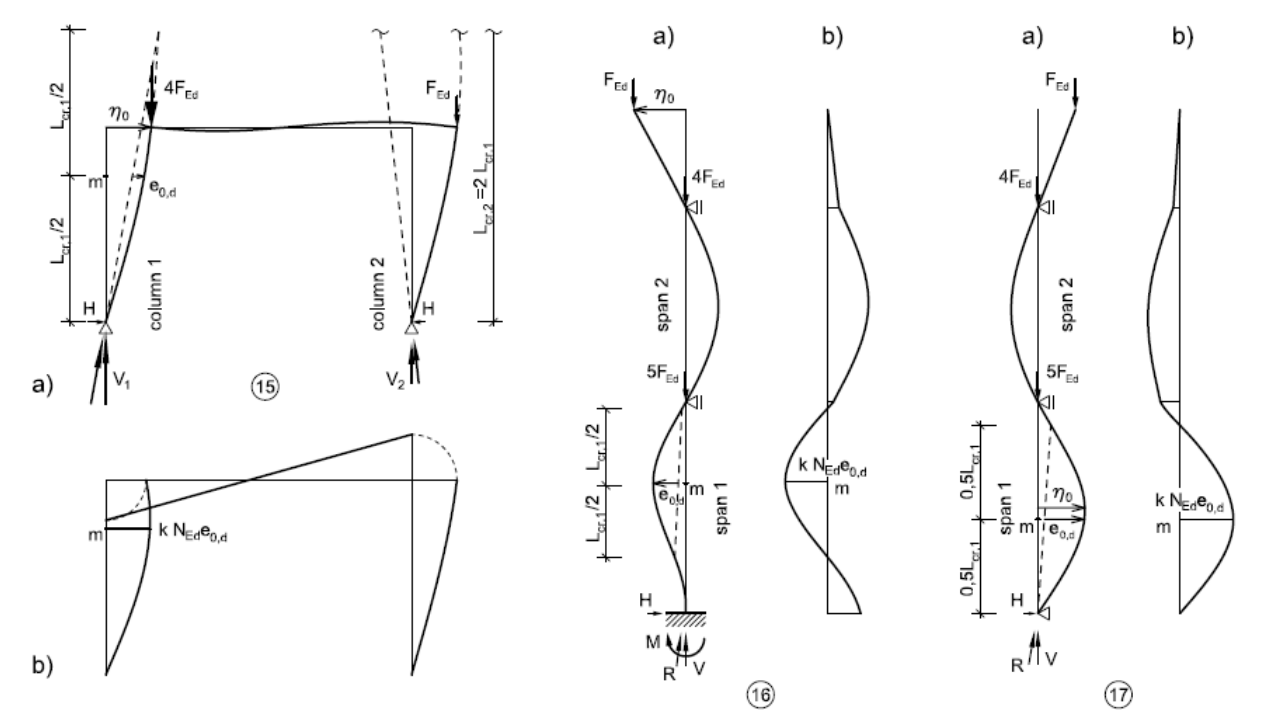
Figure 18. ( a ) UGLI imperfection and locations of e 0,d and η 0 ; ( b ) bending moment distributions and locations of maximum moment 𝑀 (cid:2889)(cid:2914)(cid:2893)(cid:2893) = 𝑘𝑀 (cid:2889)(cid:2914)(cid:2893) = 𝑘𝑁 (cid:2889)(cid:2914) 𝑒 (cid:2868),(cid:2914) in critical point m for cases No.15– No.17.